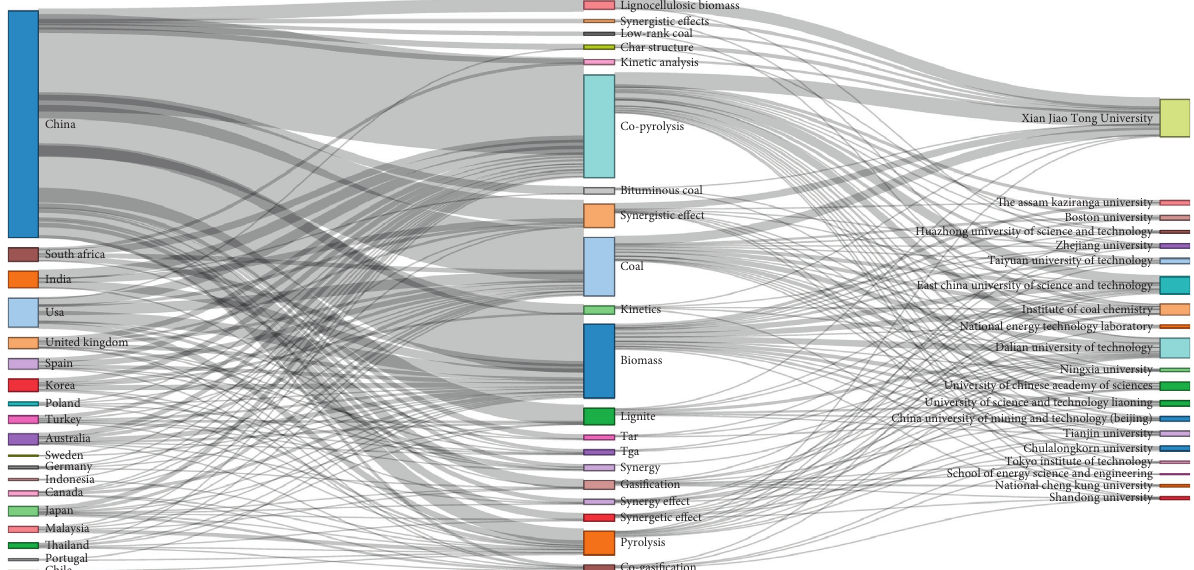
Figure 3: Sankey three-field plot of